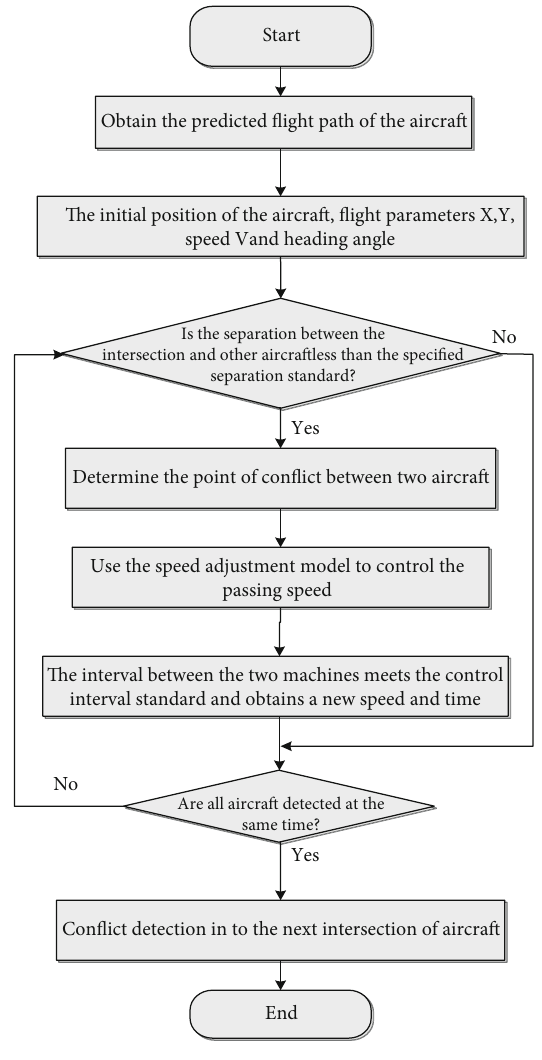
Figure 5: Route planning process of aircraft con fl ict-free